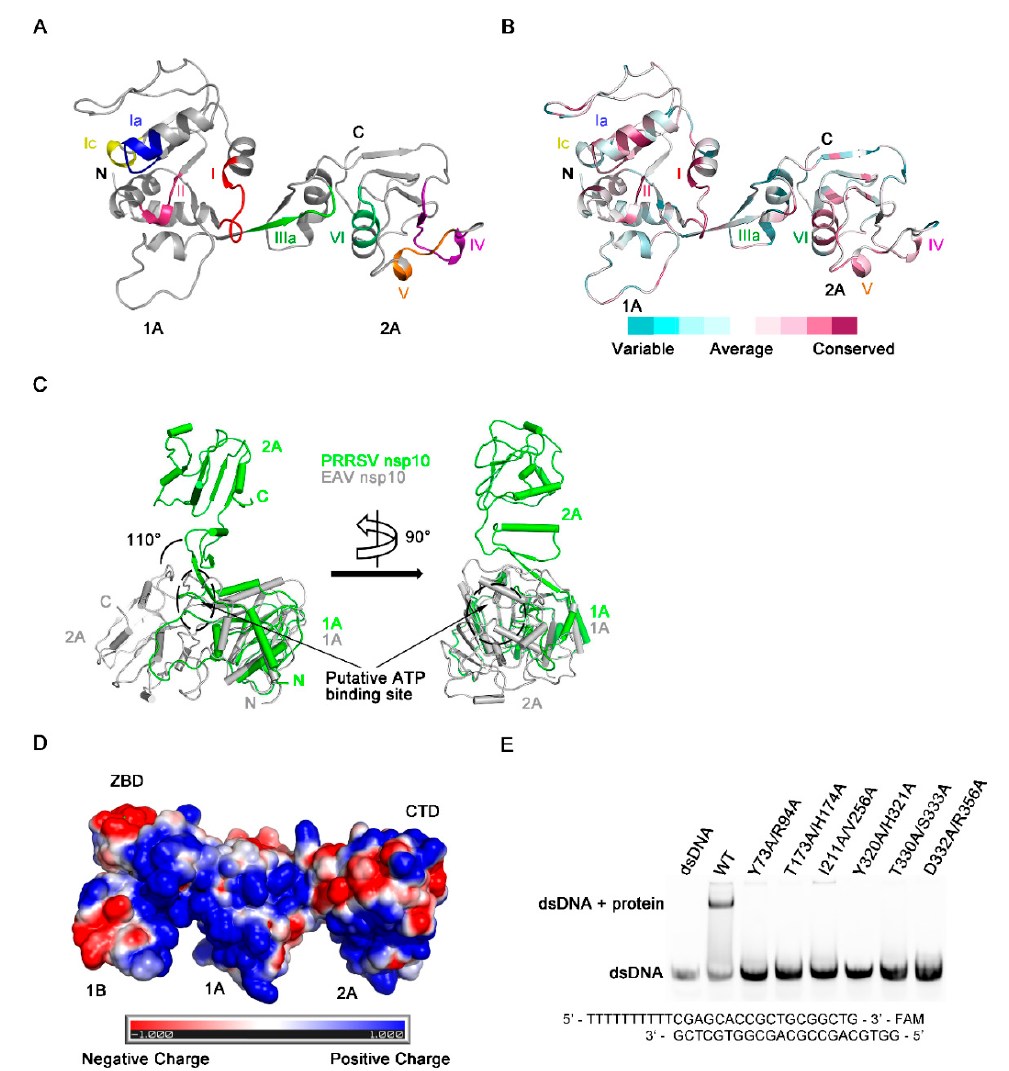
Figure 5. Regions critical for enzymatic activities. ( A ) Position of conserved motifs necessary for NTP binding, hydrolysis and nucleotide binding in the structure of the PRRSV nsp10 helicase core. ( B ) The helicase core was colored by conservation calculated using Consurf [52] based on multiple sequence alignment of PRRSV nsp10, EAV nsp10, MERS-CoV nsp13, severe acute respiratory syndrome coronavirus nsp13, and lactate dehydrogenase-elevating virus nsp10 [23–25,47,53,54]. ( C ) Structural comparison of the helicase core of PRRSV nsp10 and EAV nsp10 reveals differences in structural rearrangements. These two structures are superimposed on 1A domains. The putative ATP binding site is shown as a dotted circle. A 90° rotation view is shown in the right panel. ( D ) Overview of surface charges of PRRSV nsp10. ( E ) The binding abilities of PRRSV nsp10 mutants to dsDNA are demonstrated through EMSA.